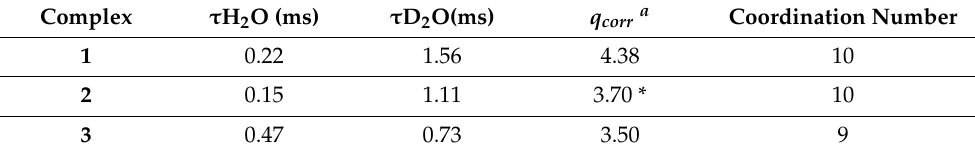
Table 1. Excited state lifetime measurements of 1 – 3 in H 2 O and D 2 O at pH 7.4 (HEPES buffer). Complex Coordination